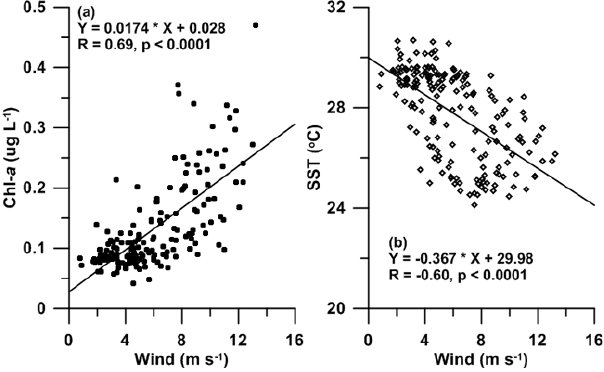
Fig. 8. The correlation between Chl and wind speed (a) and between SST and wind speed (b) . Table 2. R values from linear regressions between one another of MEI (Multivariate ENSO Index) and non-seasonal variations of en- vironmental variables at the SEATS site in the northern SCS from 1997–2011. WindA SSHA